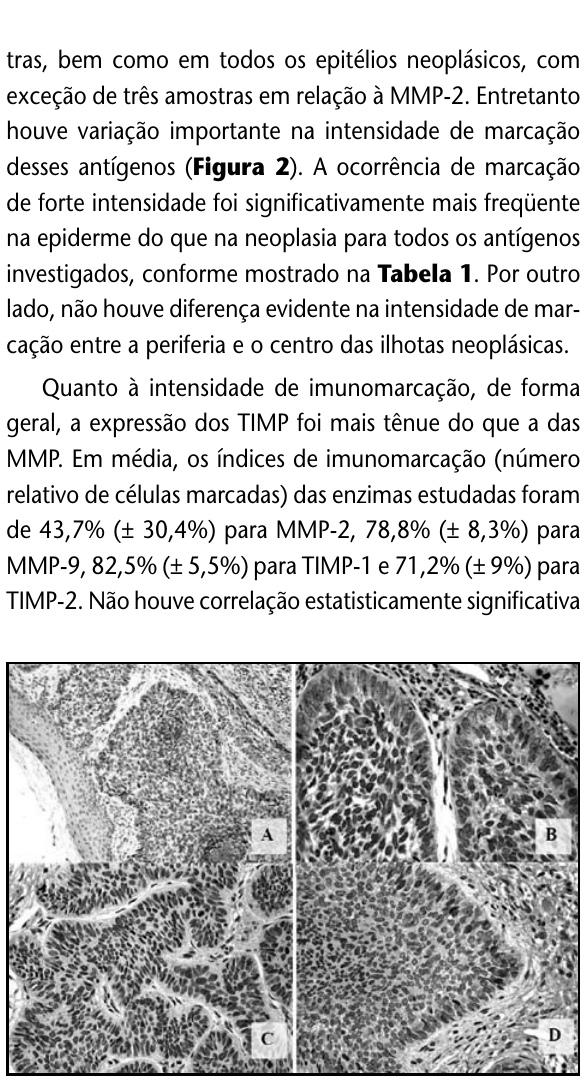
Figura 2 – Imunolocalização dos antígenos. A: MMP-2; B: MMP-9; C: TIMP-1; D: TIMP-2 em carcinoma basocelular. Notar imunolocalização de MMP-9 e TIMP-2 em fibroblastos vizinhos ao tumor (setas) (figura 4A, aumento de 200x; figuras 4B, C e D, aumento de